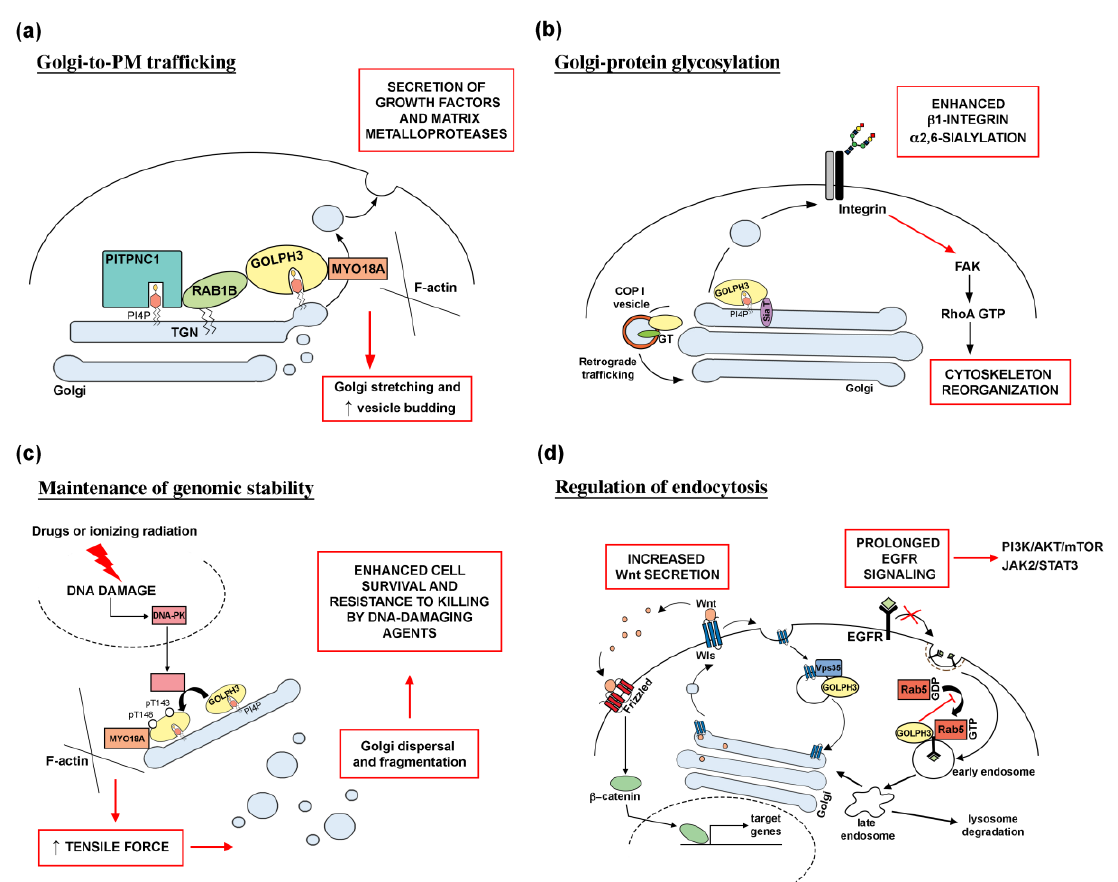
Figure 1. Molecular mechanisms underlying GOLPH3 function in human cancer. ( a ) Altered Golgi- to-PM trafficking. Recruitment of the PI(4)P-binding protein GOLPH3 at the trans-Golgi network (TGN), requires the PITPNC1/RAB1B network. Overactivation of the GOLPH3/MYO18A pathway leads to Golgi extension and enhanced vesicle release, resulting in the massive secretion of growth factors and matrix metalloproteases, which are responsible for cancer malignancy. ( b ) GOLPH3 role in Golgi-protein glycosylation. GOLPH3 is involved in COPI-mediated retrograde trafficking of several Golgi glycosyltransferases (GT). GOLPH3 protein binds to sialyltransferases (Sia T); its overexpression results in enhanced α2,6-sialylation of β1-integrins. Altered glycosylation affects